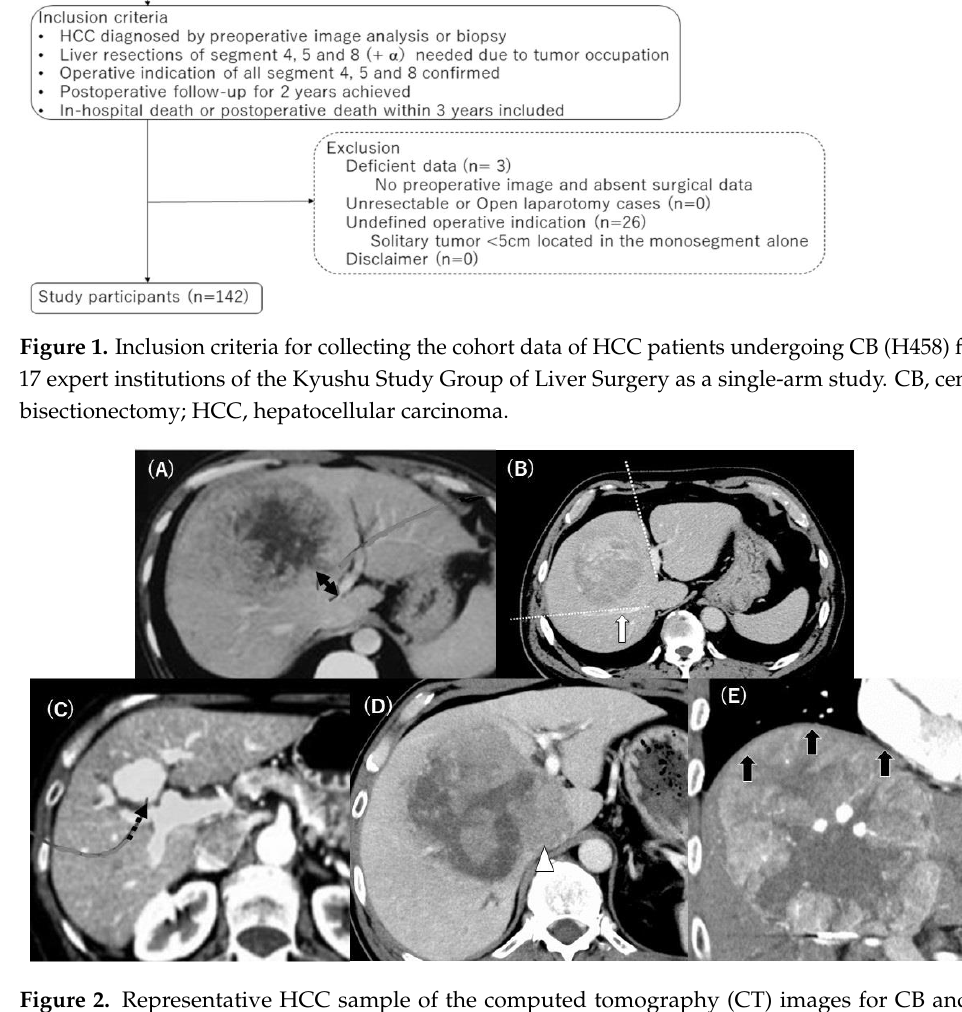
Figure 2. Representative HCC sample of the computed tomography (CT) images for CB and investigated items in the case report form for each institute: ( A ) the distance or existence of tumor compression to the hilar Glissonean pedicle (black double arrow), ( B ) the adequate transected planes required in CB (dotted white lines) and the right hepatic vein trunk and the distance or existence of compression by the tumor (white arrow), ( C ) the existence of tumor involvement in the portal or bile duct at the hepatic hilum (dotted black arrow), ( D ) tumor involvement in segment 1 (caudate lobe) except segment 4,5, and 8 or compression of IVC (white arrow head), ( E ) tumor compression of the diaphragm (black arrows). CB, central bisectionectomy; HCC, hepatocellular carcinoma.